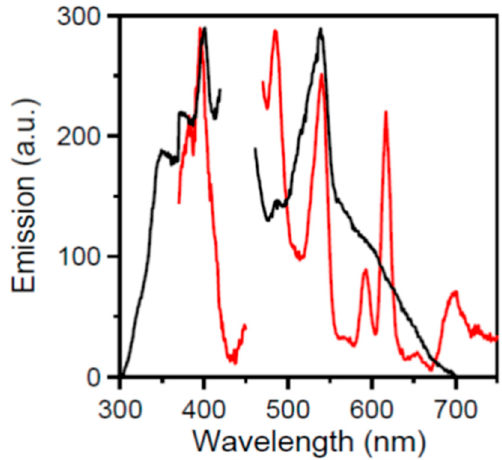
Figure 8. Solid-state, room-temperature excitation (left) and emission (right) spectra of mepaoH (black curves) and complex 2 (red curves). The emission spectra were detected at 397 nm for both compounds. The excitation spectra were detected with maximum emission at 545 nm for mepaoH and 618 nm for 2 .